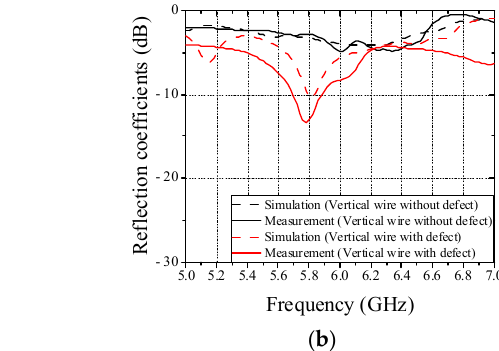
Simulation (Horizontal wire without defect) Measurement (Horizontal wire without defect) Simulation (Horizontal wire with defect) Measurement (Horizontal wire with defect)